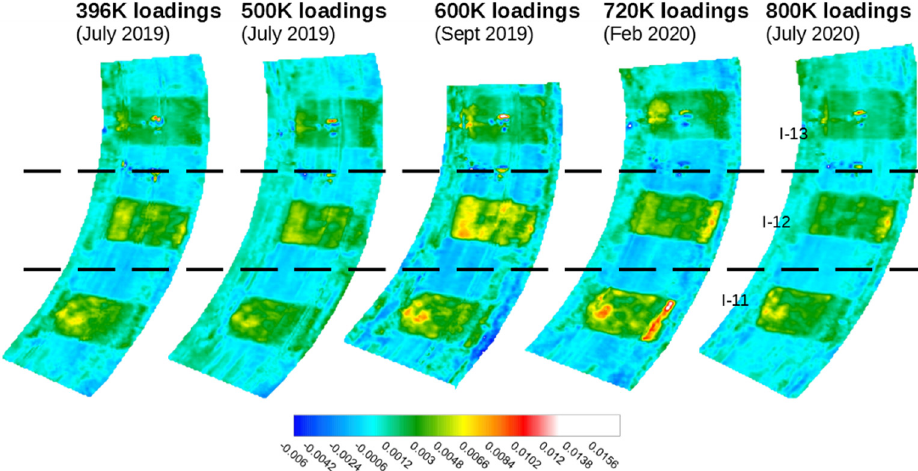
Figure 10. Maps of the reflected echo at the defect interface extracted from C-scans in the area of I-11 to I-13 (values in Legend refer to the amplitude of the received signal).